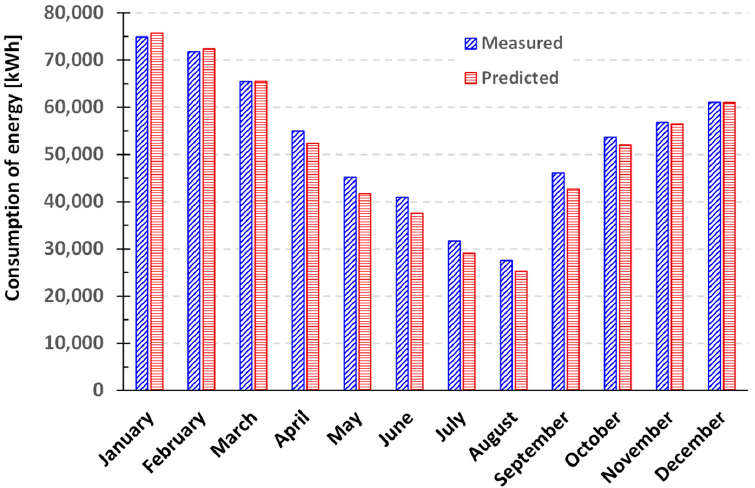
Figure 2. Measured versus predicted energy consumption of the high school during 2014.